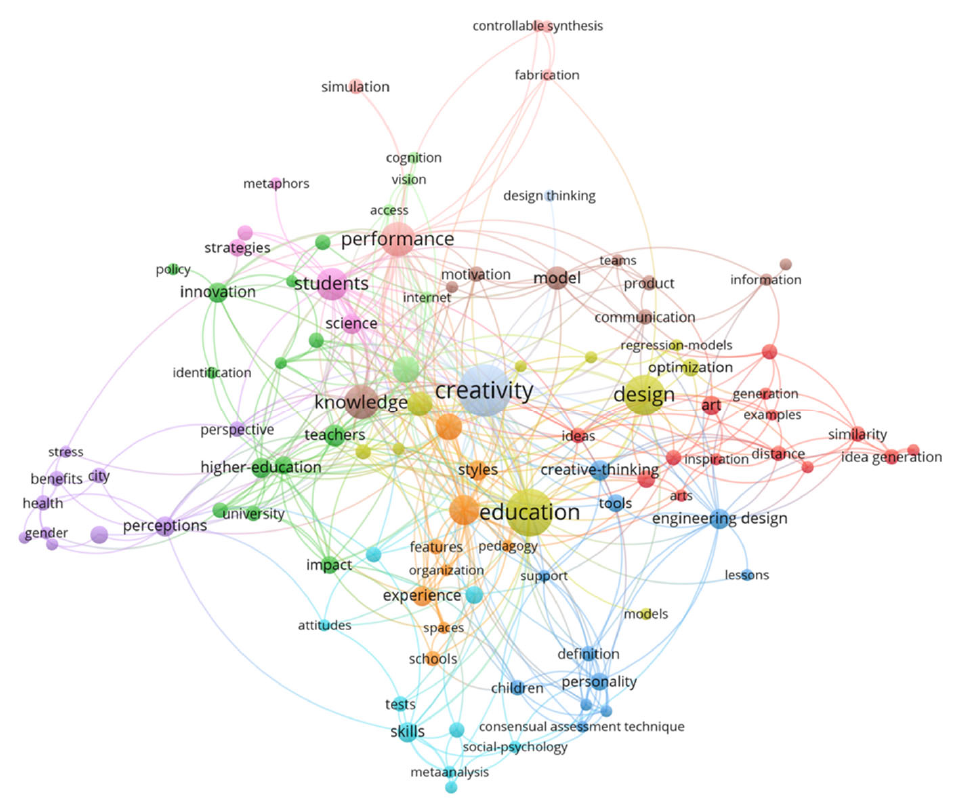
Figure 6. Co-occurrence network of author keywords (min. number of occurrences: two) in Figure 6. Co ‐ occurrence network of author keywords (min. number of occurrences: two) in WoS.